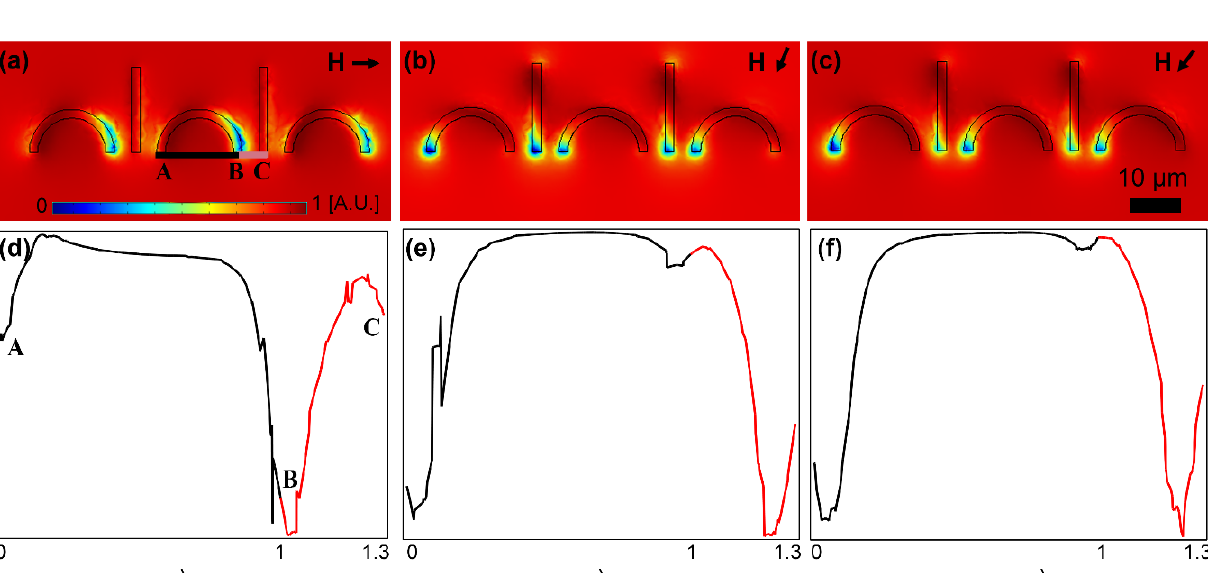
Figure 8. The particle transport failure from the I bar tip, in an unsuitable β y = − 1.52, is studied. ( a – c ) The potential energy distributions for three sequential magnetic field directions are illustrated. ( d – f ) The energies along the lines AB and BC (see ( a )) for the field directions of ( a – c ) are plotted in ( d – f ), respectively. The small black arrows stand for the magnetic field directions. The field is rotat- ing clockwise. The energies are plotted at the center of a particle with a radius of 2.5 µm. The blue and red areas indicate the regions with low and high potential energies, respectively. Thus, shifting the I bars in the − y direction can be problematic. The I bars are consid- ered in the design to hold the particle until the next energy well appears on the next C- shaped magnet to capture it and move it forward. When the I bars are shifted in the +y direction, at some point the energy well on their tips is too far from the particle on the C- shaped magnet (results not shown here). This particle will see a closer energy well on the next C-shaped magnet. Thus, if the particle can be held on the first C-shaped magnet for